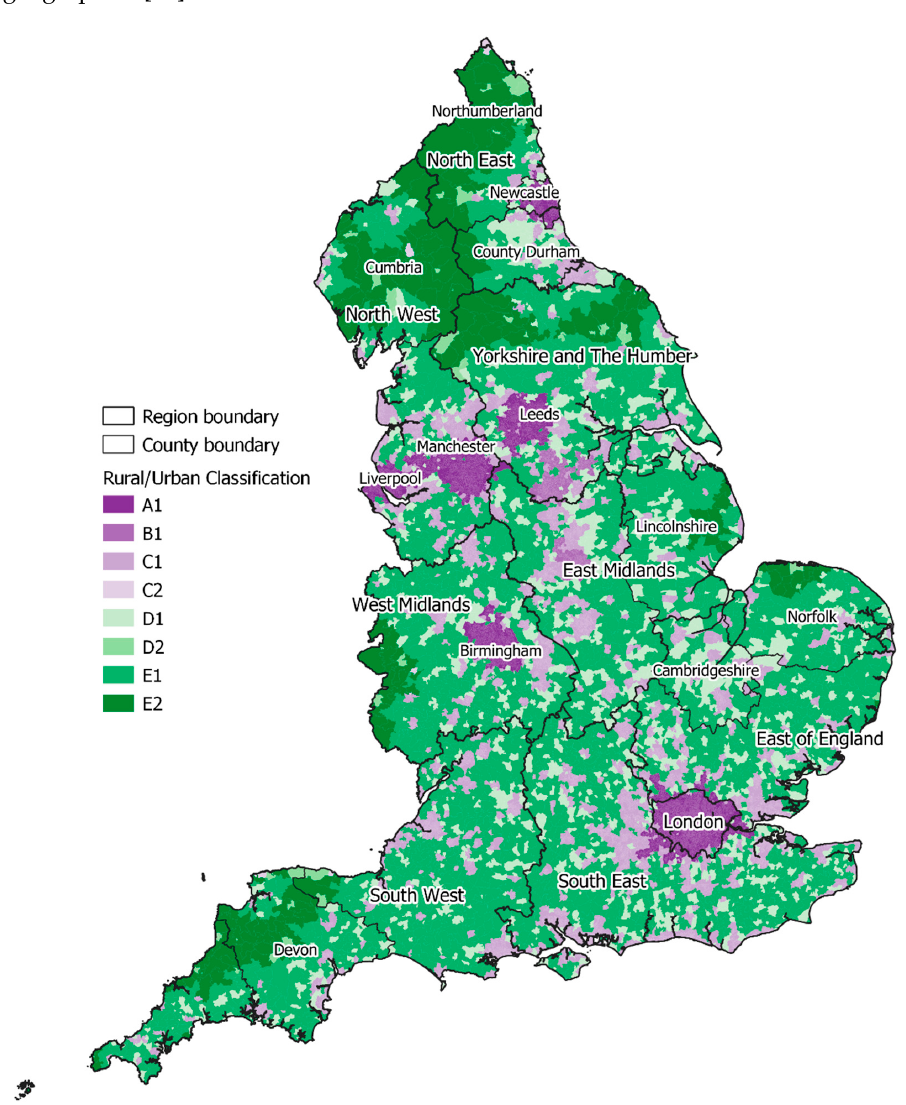
Figure A1. Reference and contextual map to support the discussion in Sections 3 and 4.